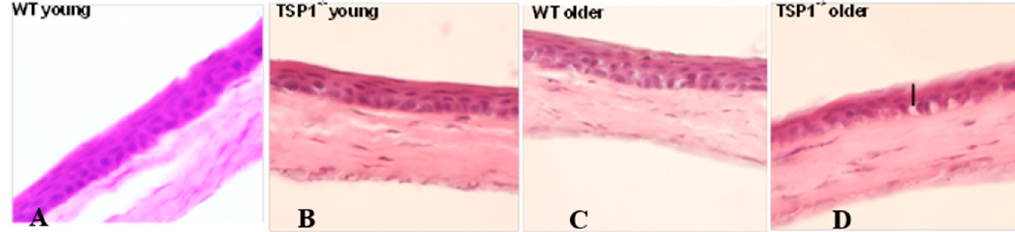
Figure 1. Hematoxylin and Eosin staining of corneas from young (4-week-old) wild type ( A ), young (4-week-old) thrombospondin-1-deficient (TSP-1 − / − ) ( B ), older (12-week-old) wild type ( C ), and older (12-week-old) TSP-1 − / − ( D ) mice showed no apparent inflammatory cells. No apparent morphological changes were observed between 4-week-old mice. Twelve-week-old TSP-1-deficient mice displayed a thinner epithelial layer and an uneven line of basal epithelial cells containing interspersed elongated cells with vacuoles (indicated with a black bar).